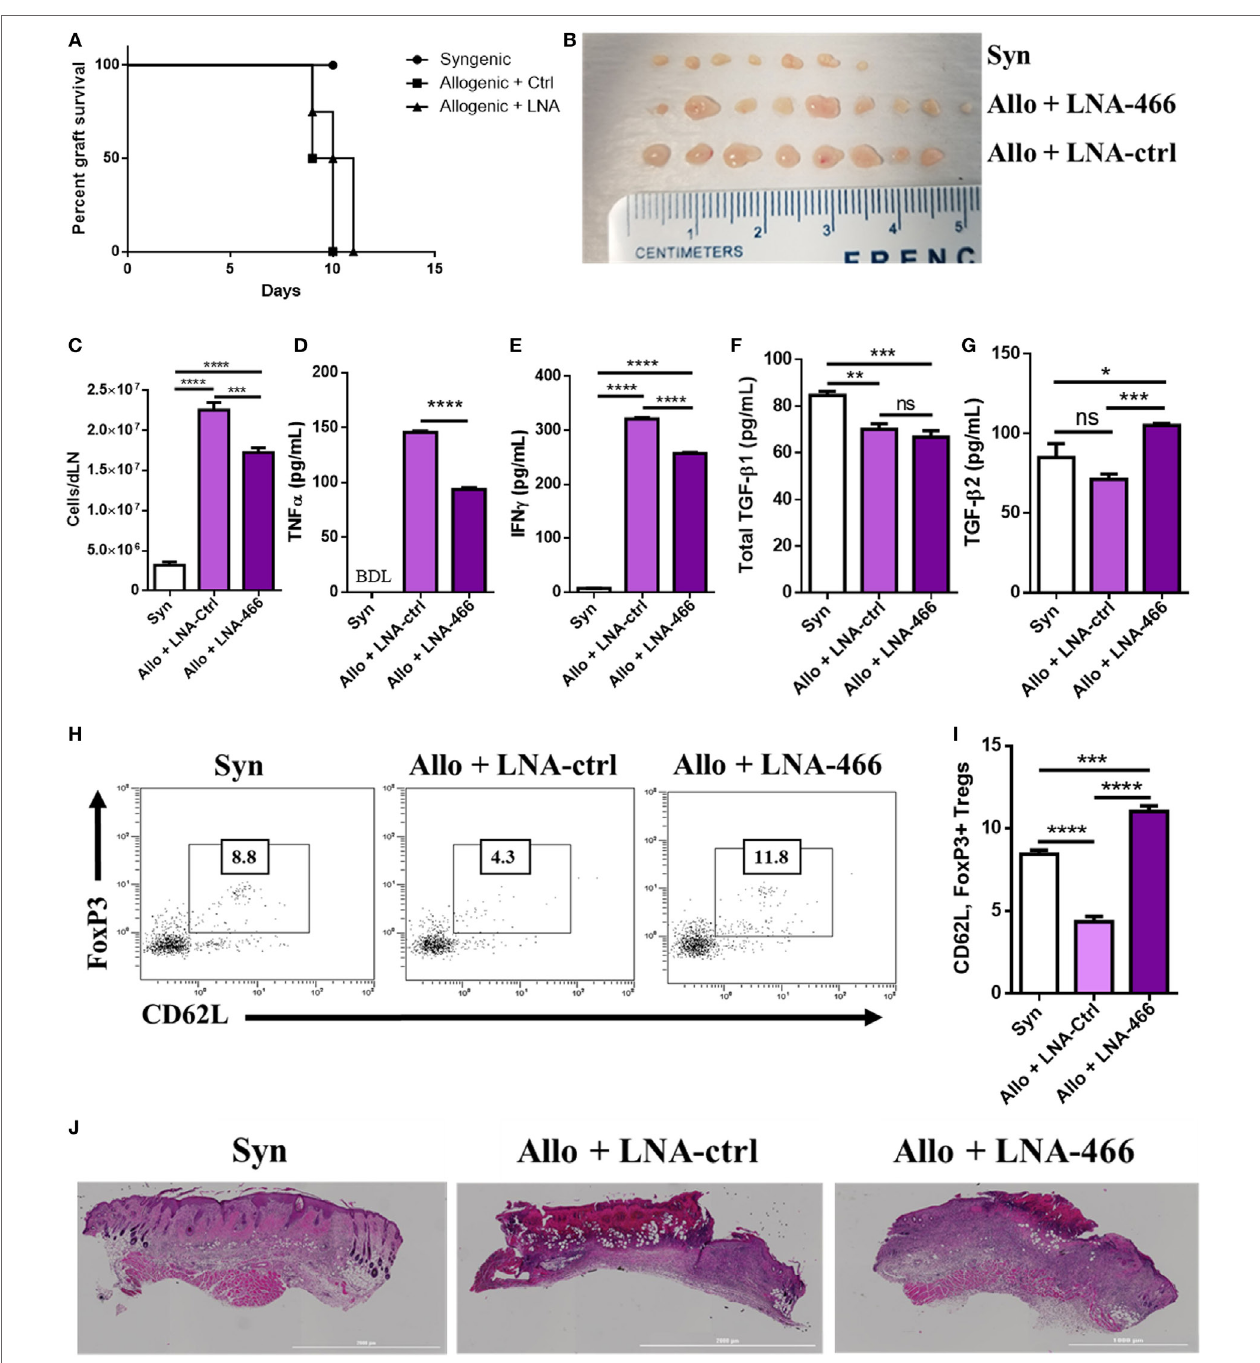
FigUre 5 | Locked nucleic acid (LNA) mitigates draining lymph node (dLN) effector cell and cytokines. Female C57BL/6 mice were given either syn (BL6) or allo (C 3 H) tail skin grafts. Mice receiving allografts were given either LNA-466 (10 mg/kg) or LNA-Ctrl (10 mg/kg) intraperitoneally 1 day before skin transplantation and every third day after that until termination of the study. (a) Survival curve of mice receiving skin transplants and indicated LNA or controls; n = 4 (syngeneic), 7 (allogeneic + Ctrl), or 8 (allogeneic + LNA). dLNs were harvested 12 days after skin transplantation from indicated groups imaged in (B) , and absolute cell counts were taken in (c) . dLN cells were plated overnight in complete media and culture supernatants were harvested and subjected to enzyme-linked immunosorbent assay (ELISA) for TNF α (D) and IFN γ (e) . Serum was taken upon sacrifice and subjected to ELISA for transforming growth factor (TGF)- β 1 (F) and TGF- β 2 (g) . Dot plots of circulating cells double positive for FoxP3 and CD62L, data are gated on CD4 + cells (h) , and quantified in (i) . (J) Hematoxylin & eosin stains of grafts excised from mice upon sacrifice. Data are presented as mean ± SEM; n = at least 4 per group. * P < 0.05, ** P < 0.005, *** P < 0.001, **** P < 0.0001 by ANOVA with Tukey’s multiple comparisons test.